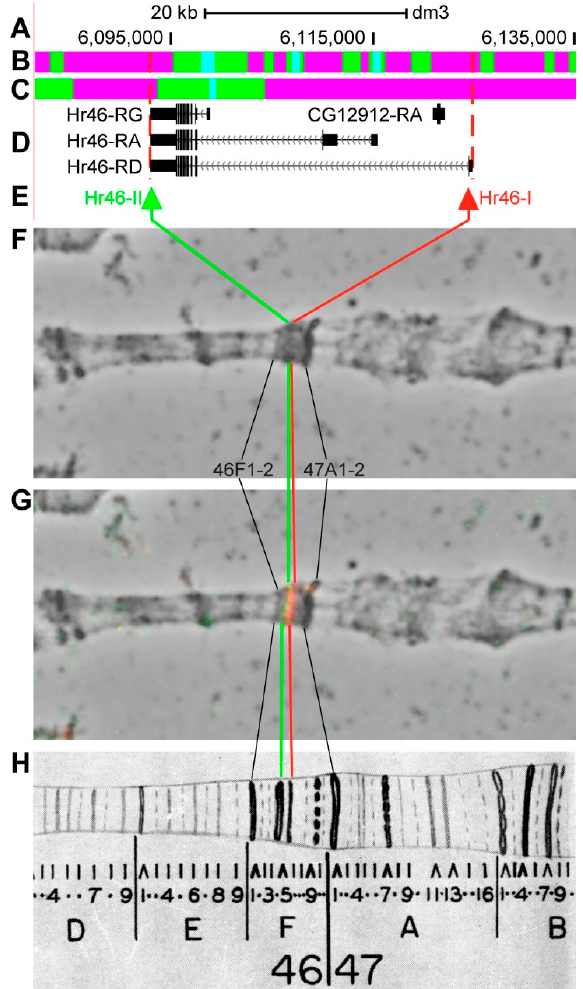
Figure 17. Localization of the Hr46 gene in the 46F region (the gene is bound by red dotted lines). (A) the scale (kb) and genomic coordinates (bp); (B) the four chromatin-state model [39]; (C) the chromatin ( A ) the scale (kb) and genomic coordinates (bp); ( B ) the four chromatin-state model [39]; ( C ) the condensation level model [32]; (D) genes location (arrow lines show the gene orientation and black chromatin condensation level model [32]; ( D ) genes location (arrow lines show the gene orientation bars indicate the location of gene exons); (E) probes location; (F) phase-contrast micrograph of the and black bars indicate the location of gene exons); ( E ) probes location; ( F ) phase-contrast region; (G) combined FISH signals; and, (H) C. Bridges’ chromosome map [25].